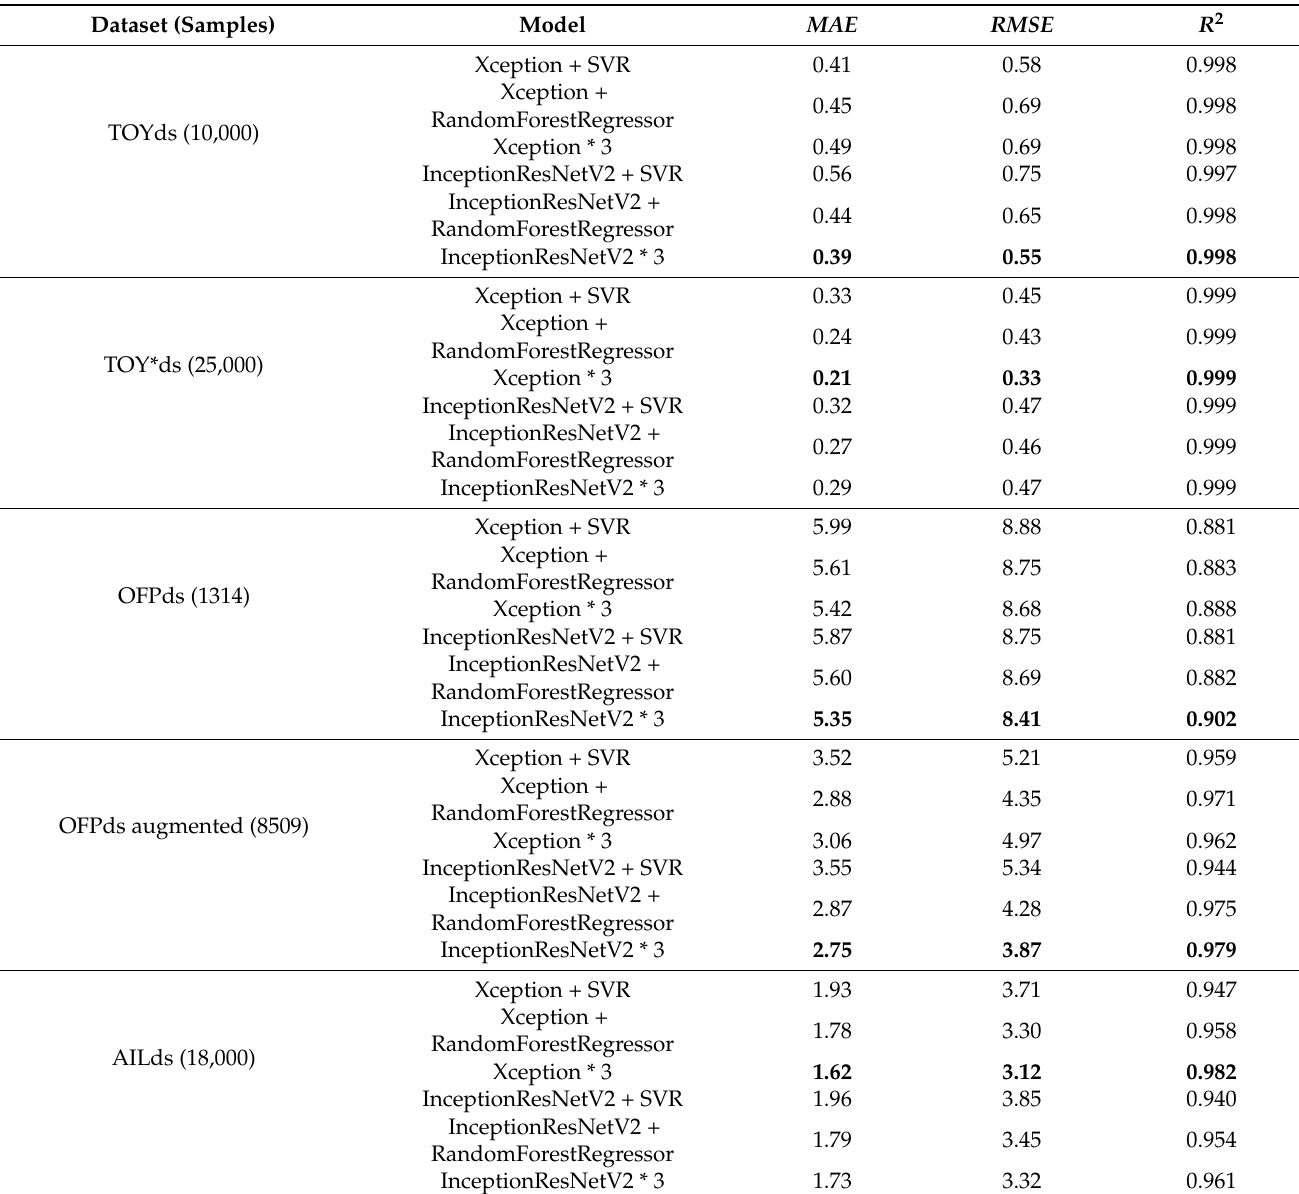
Table 2. The prediction performance of the hybrid/ensemble models on the test